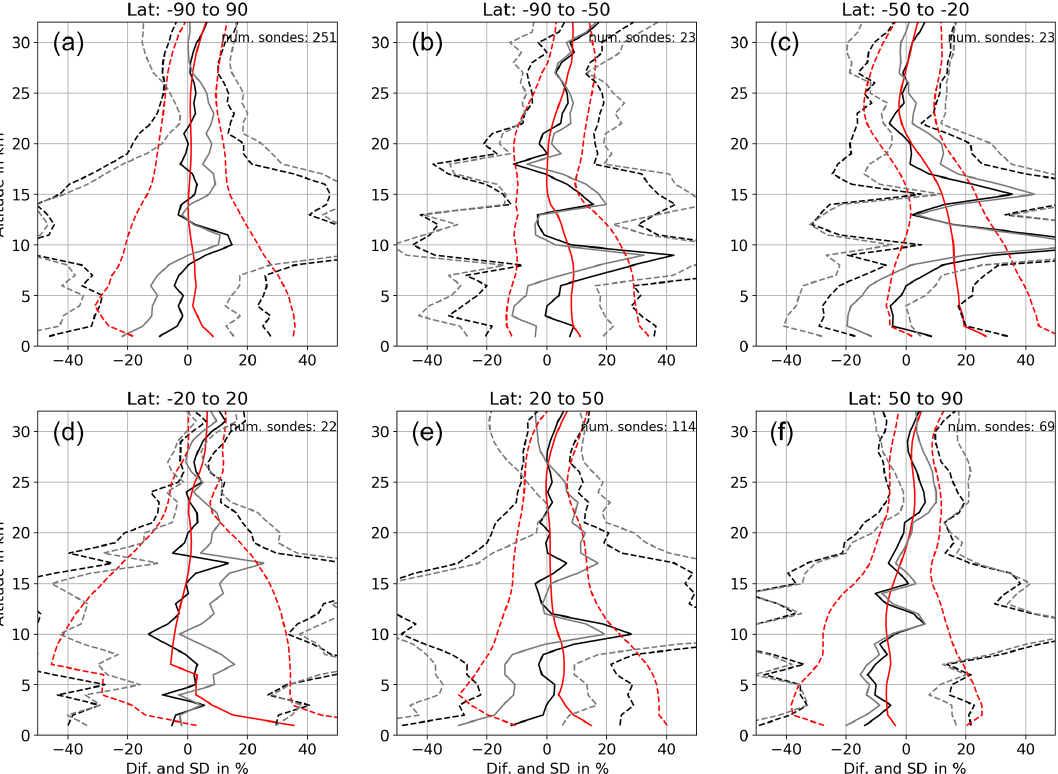
Figure 7. Comparison of the ozone profiles retrieved from TROPOMI and those from ozonesondes for different zonal bands. The relative mean difference between the retrieval results and the high-resolution sonde data (solid line), as well as the standard deviation of the differences (dashed line), is shown in black. The comparison with the sonde profiles convolved with the TOPAS averaging kernels is shown in red. In grey the relative difference between the a priori ozone profiles and high-resolution ozonesonde profiles is displayed, along with the corresponding standard